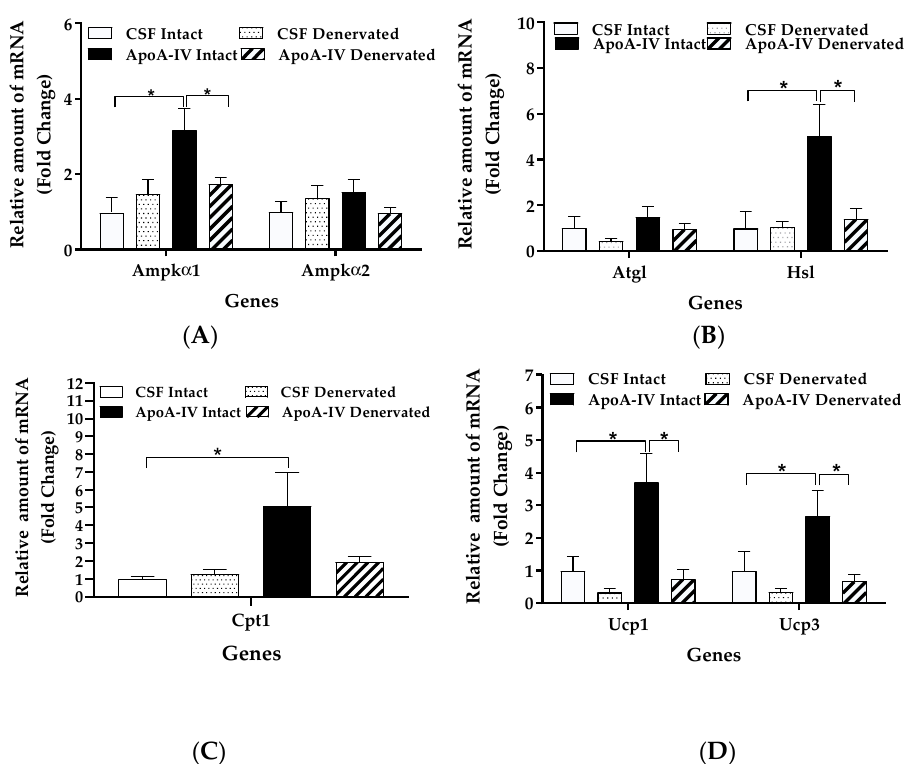
Figure 5. Lipolytic and thermogenic gene expression in intact and denervated BAT. Levels of Ampk α 1 and Ampk α 2 ( A ), Atgl and Hsl ( B ), Cpt1 ( C ), and Ucp1 and Ucp3 ( D ) gene expression in intact and denervated BAT were measured by qRT-PCR. Mice with unilateral denervation of BAT received central administration of either CSF (1 µ L) or ApoA-IV (12 µ g) into the third ventricle, and BAT was collected at 40 min post-injection. Data are expressed as the means ± SEM for 6–8 mice per group. * Represents a significant difference relative to CSF-treated controls ( p < 0.05). Table 2. Experiment 2: Body weight, tissue weights, and levels of plasma parameters. After fasting for five hours, mice (n = 7/group) received intracerebral administration of either CSF (1 µ L) or recombinant ApoA-IV protein at 12 µ g/ µ L (1 µ L). Plasma and tissues were collected 40 min after injections. Values are presented as the means ± SEM. BW: body weight; BAT: brown adipose tissue; EWAT: epididymal white adipose tissue; IWAT: inguinal white adipose